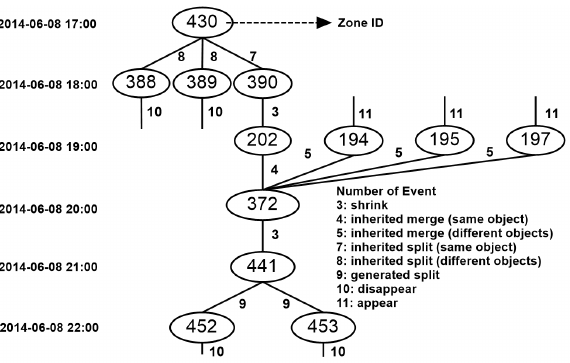
Figure 10: Evolutionary trajectories of urban heat islands